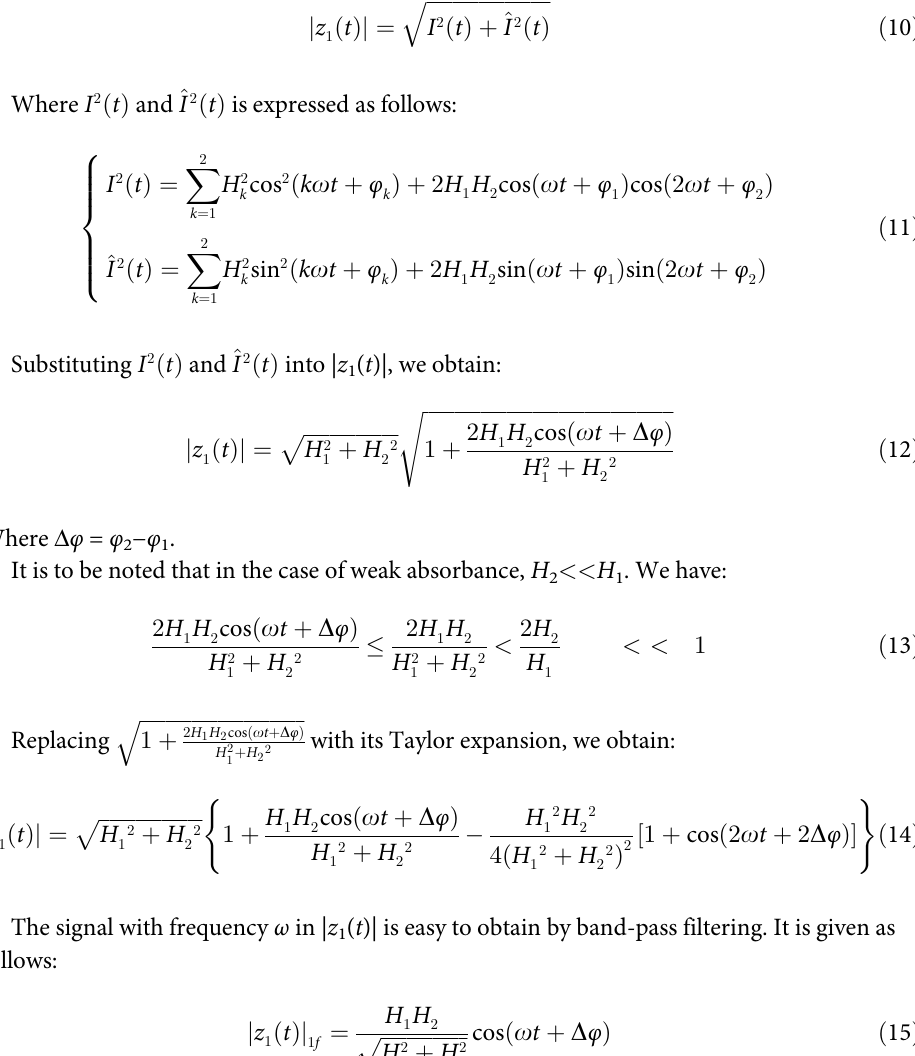
Fig 1. Flow diagram for the process of second harmonic demodulation. Envelope extraction processes are based on the Hilbert